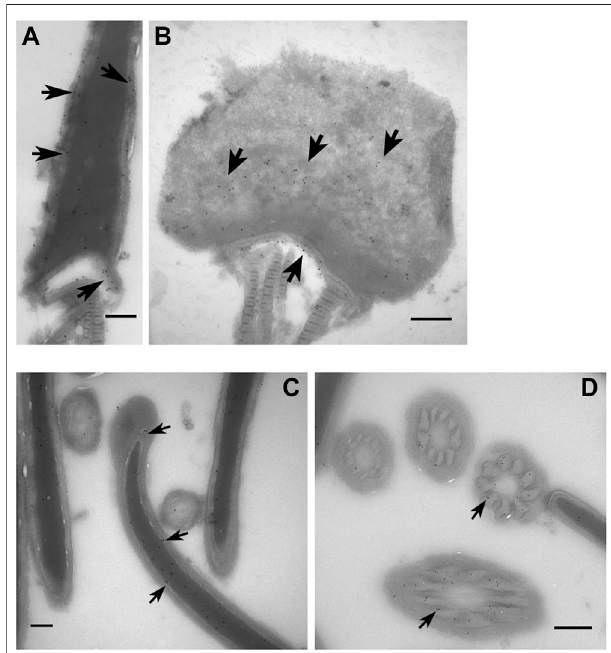
FIGURE 5 | Ultrastructural localization of PAWP and RAB2B in boar spermatozoa. Immunogold labelling of PAWP on sagittal sections (A) and oblique sections through the post acrosomal sheath (PAS) region and (B) through a whole sperm head showing that PAWP localized to the PAS- PT and the connecting piece (arrow). (C) Immunogold labelling of RAB2B on sagittal section through a whole sperm head showing RAB2B localized to the sub-acrosomal layer and the sperm nucleus. (D) Immunogold labelling of RAB2B on cross sections of the sperm tail showing RAB2B localized to the outer dense fi bers. Scale bar = 200